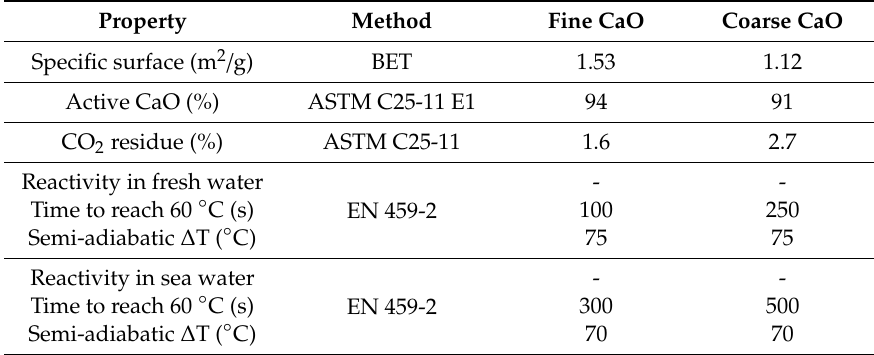
Figure 5. Physical appearance of fine CaO to the left and coarse CaO to the right. Table 4. Properties of fine and coarse burnt